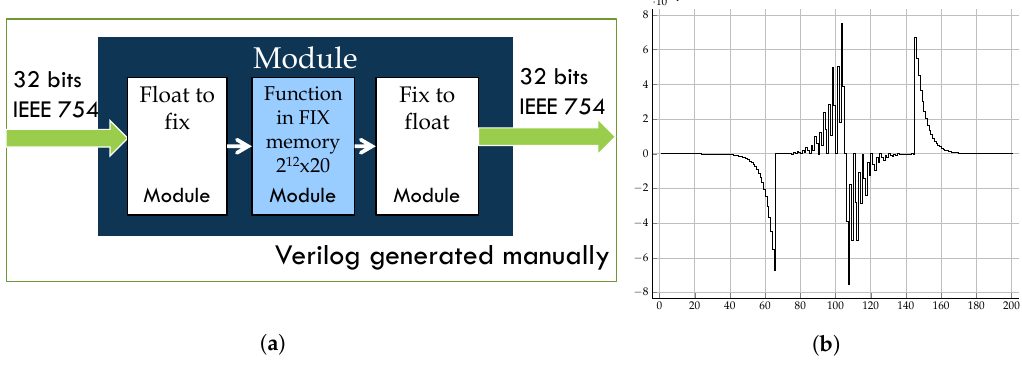
Figure 5. Implementation of tanh. ( a ) Structure of RTL tanh implementation; ( b ) error of the RTL tanh implementation.